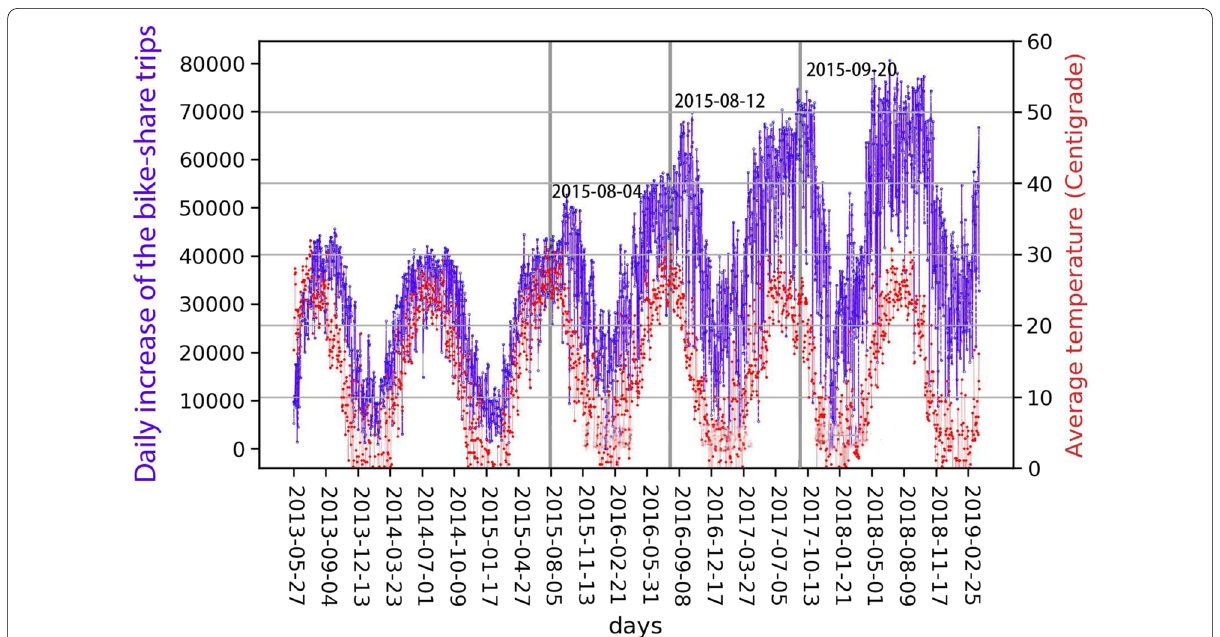
Fig. 6 Temperature and daily